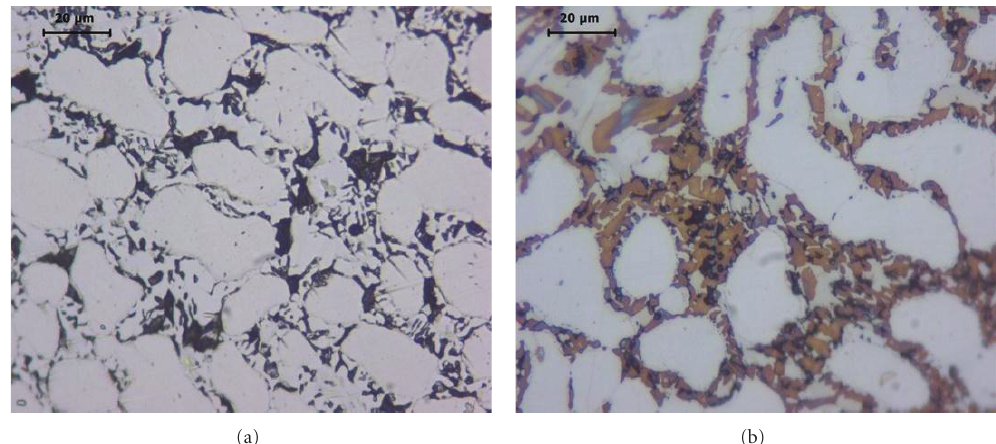
Figure 9: Optical micrographs after DLEPR test for sample aged at 800 ◦ C for 1000 min. (a) After slightly polished (large austenite in white, attacked regions in black, sigma: small white regions). (b) Electrolytically etched with NaOH (austenite in white, sigma in brown, attacked regions in black).